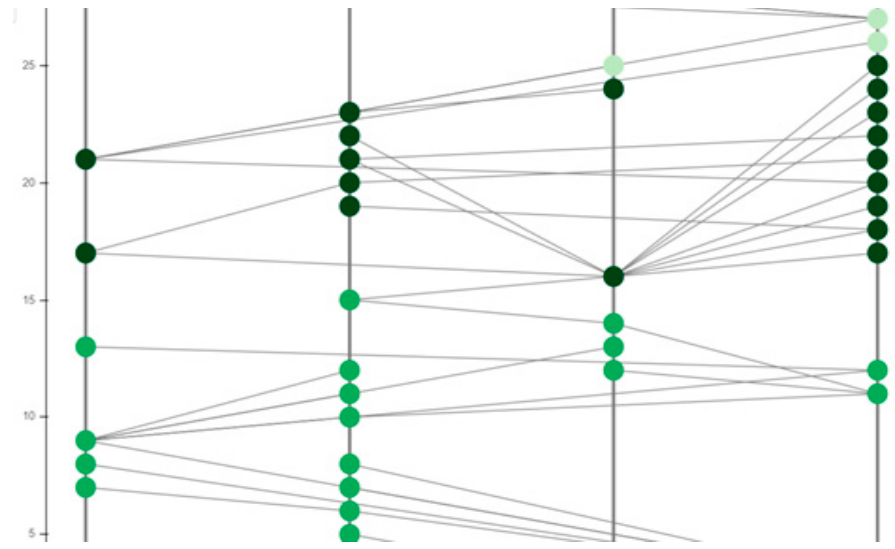
Figure 8. Implementation of hashgraphs on OMNeT++.